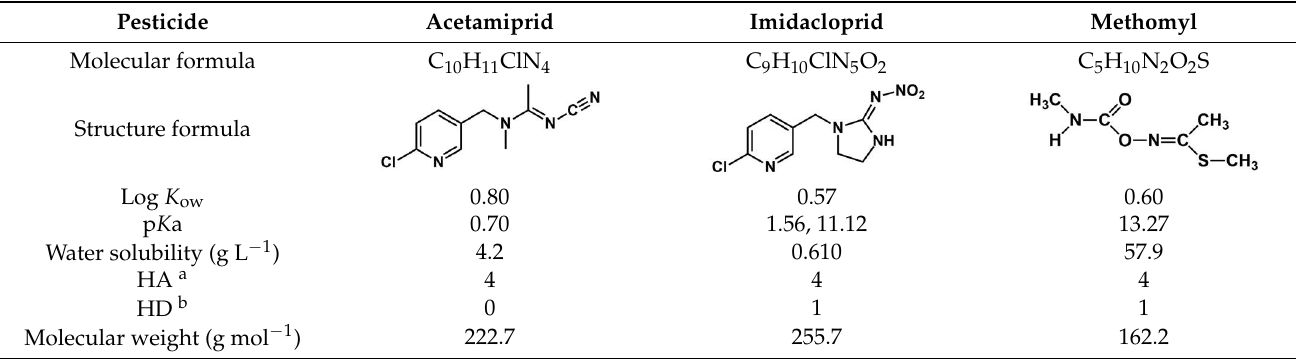
Table 2. Characteristics of pesticides. a HA: Hydrogen bonding acceptor index; b HD: hydrogen bonding donor index.